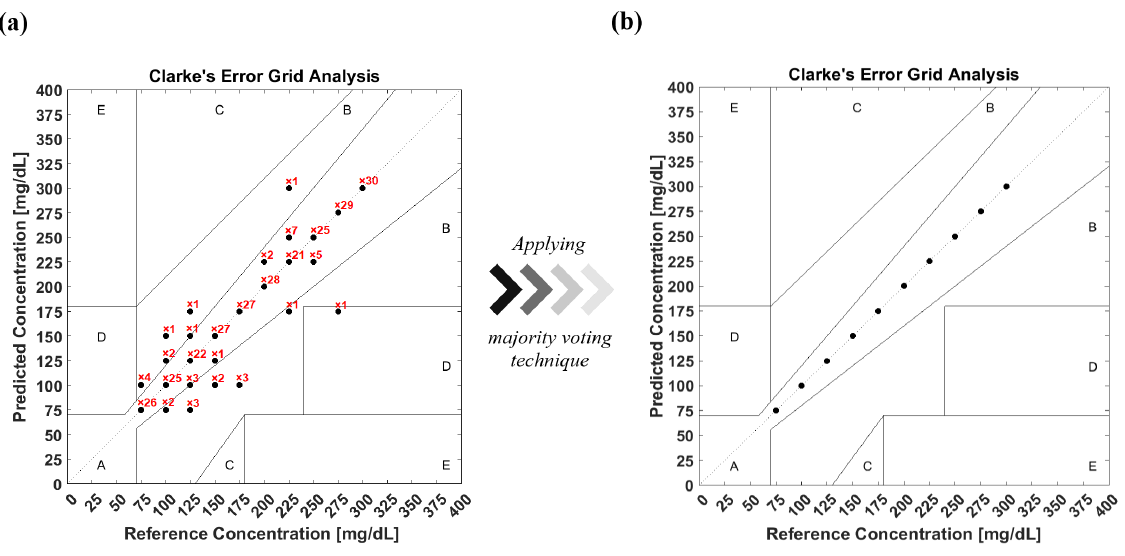
Figure 11. ( a ) Clarke’s EGA of the prediction model of glucose detection before applying the majority voting algorithm. ( b ) Clarke’s EGA of the prediction model after applying the majority voting algorithm.